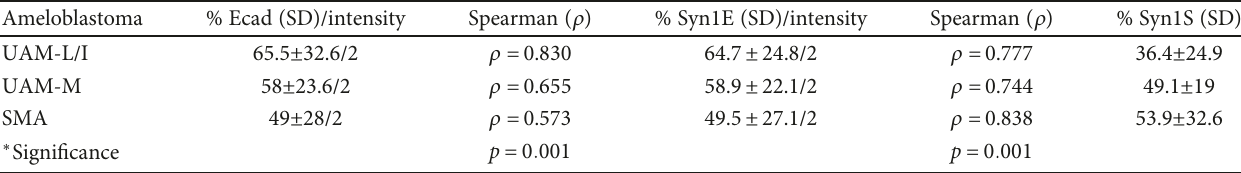
∗ Statistical signi fi cance at p < 0 05 , expression versus intensity. Ecad=E-cadherin expression; Syn1E=epithelial expression of syndecan-1; Syn1S= stromal expression of